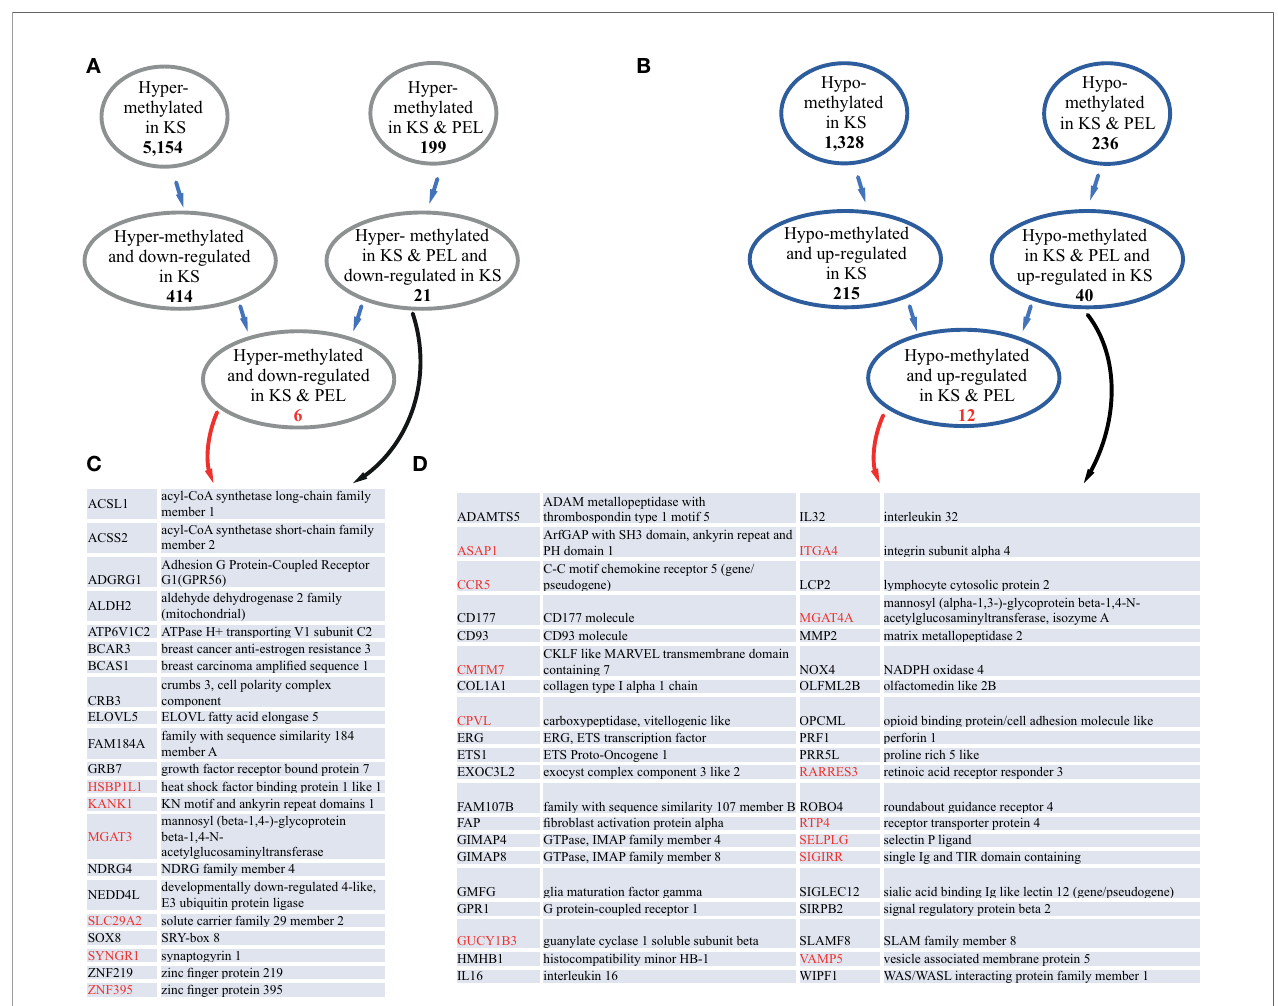
FIGURE 4 | KS and PEL share common differentially methylated promoters. (A) The number of hyper-methylated promoters common in KS and PEL, and down- regulated are indicated. (B) The number of hypo-methylated promoters common in KS and PEL, and up-regulated are indicated. (C) Gene names and their descriptions for hyper-methylated promoters common in KS and PEL, and down-regulated in KS are indicated. Genes that are also down-regulated in PEL are indicated in red. (D) Gene names and their descriptions for hypo-methylated promoters common in KS and PEL, and up-regulated in KS are indicated. Genes that are also up-regulated in PEL are indicated in